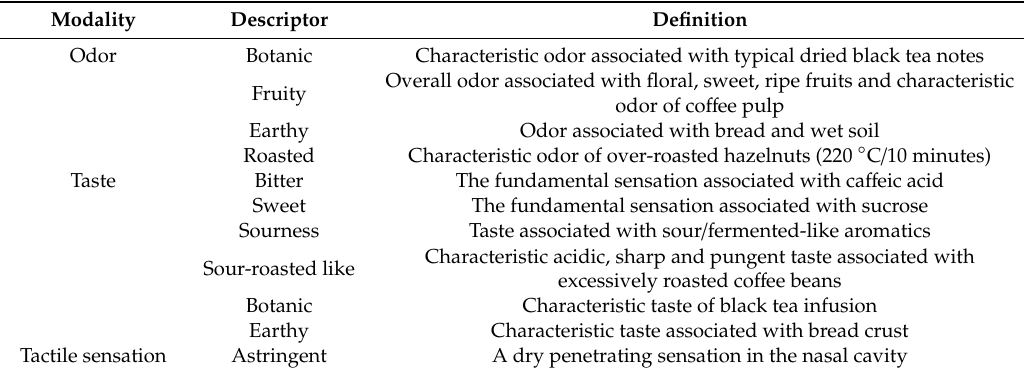
Table 4. Developed attributes and references standards in the sensory